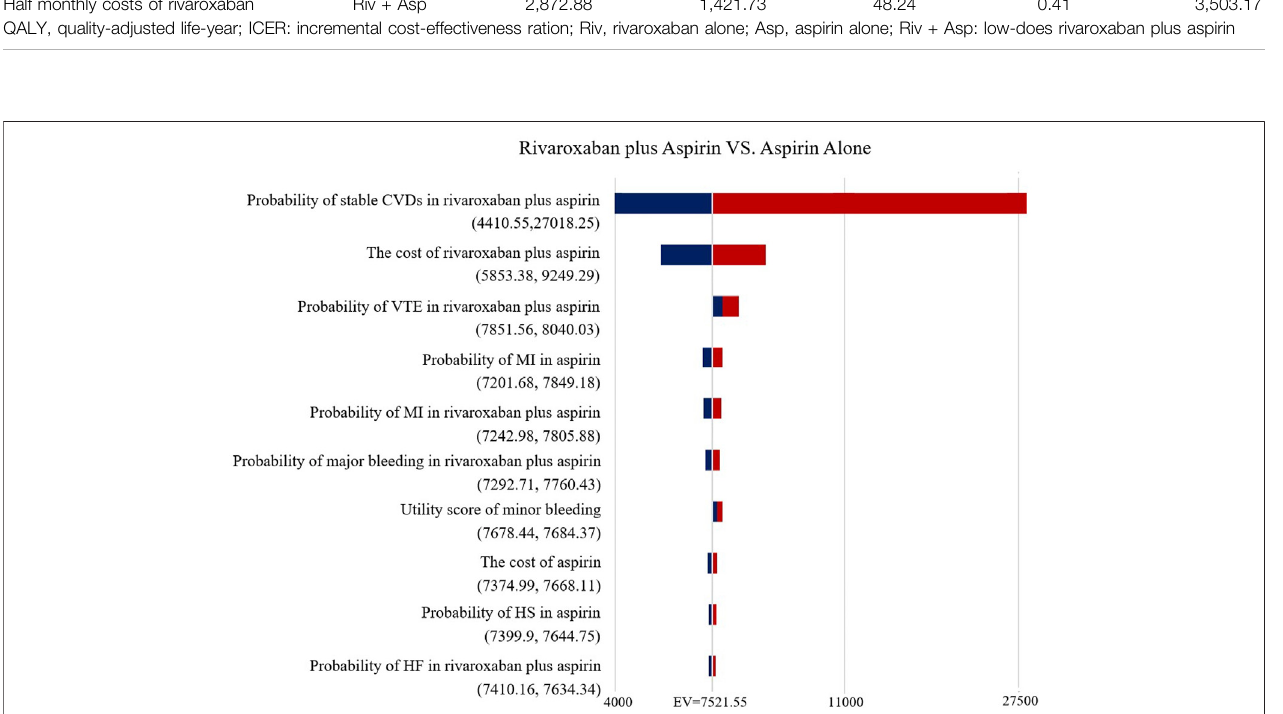
Frontiers in Pharmacology |